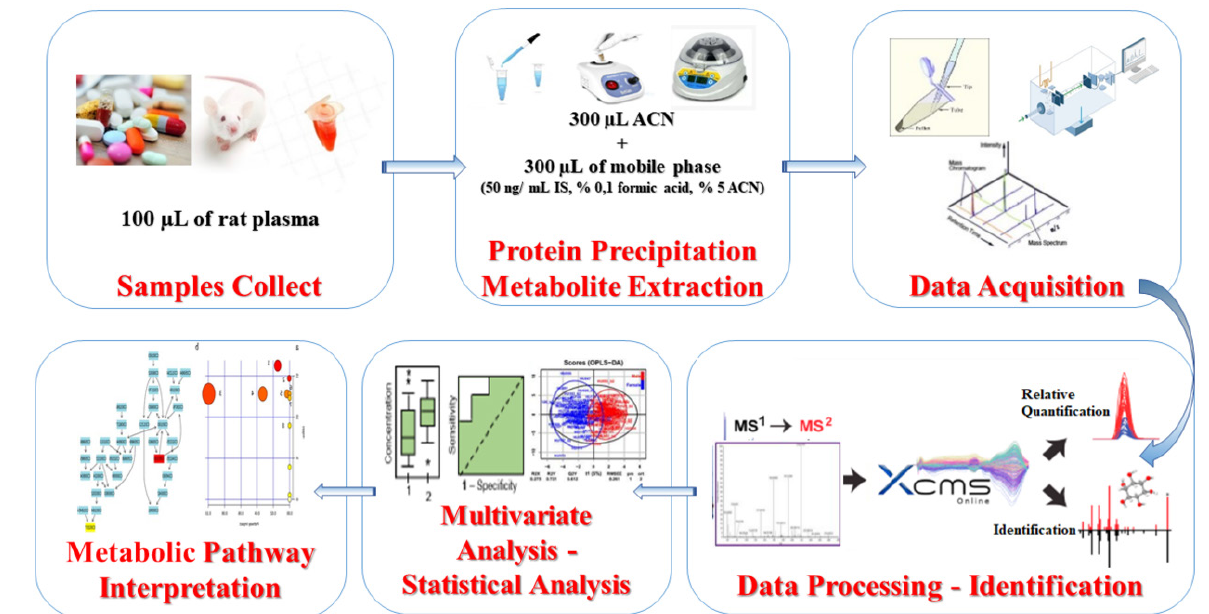
FIGURE 1 - Schematic representation of the metabolomic